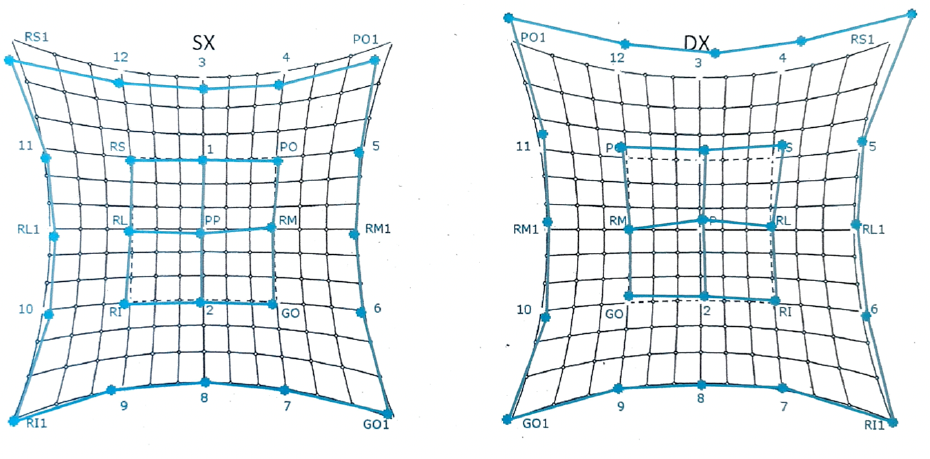
Figure 2. Pre-operative Hess–Lancaster test.